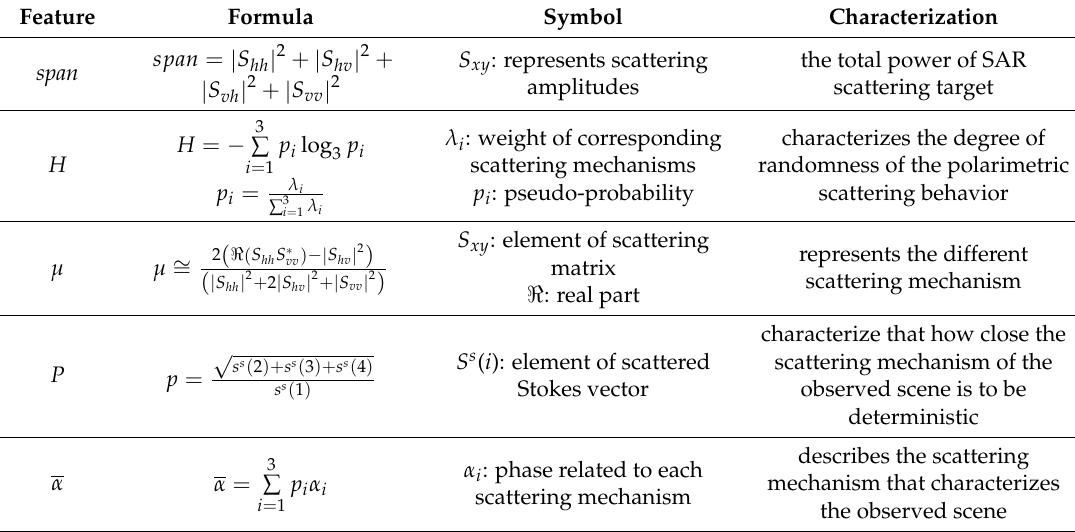
Figure 7. J-M distance index of different fully Pol-SAR features of Dataset 1 and Dataset 2. span: backscattered energy [8]; ρ : co-polarized complex correlation [7]; H: polarization entropy [1]; A: anisotropy coefficient [25]; α : mean scattering angle [25]; µ : conformity coefficient [15]; P: degree of polarization [22]. Table 4. Introduction of selected full pol-SAR features used in this study.